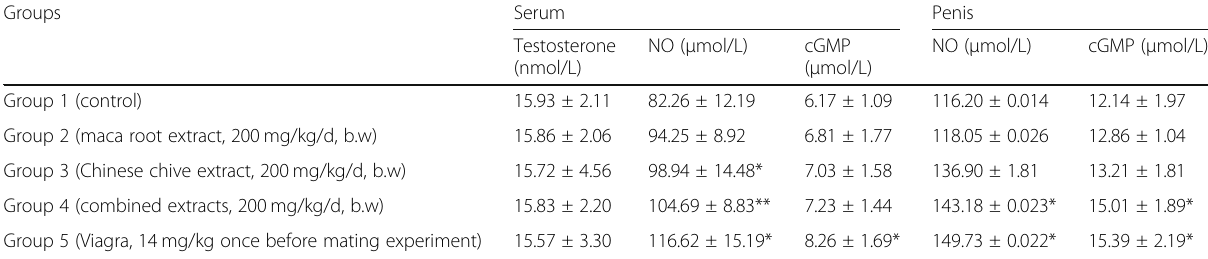
Table 2 Effects of maca root extract, Chinese chive extract and combined extracts on testosterone, NO and cGMP levels (mean ± SD) Groups